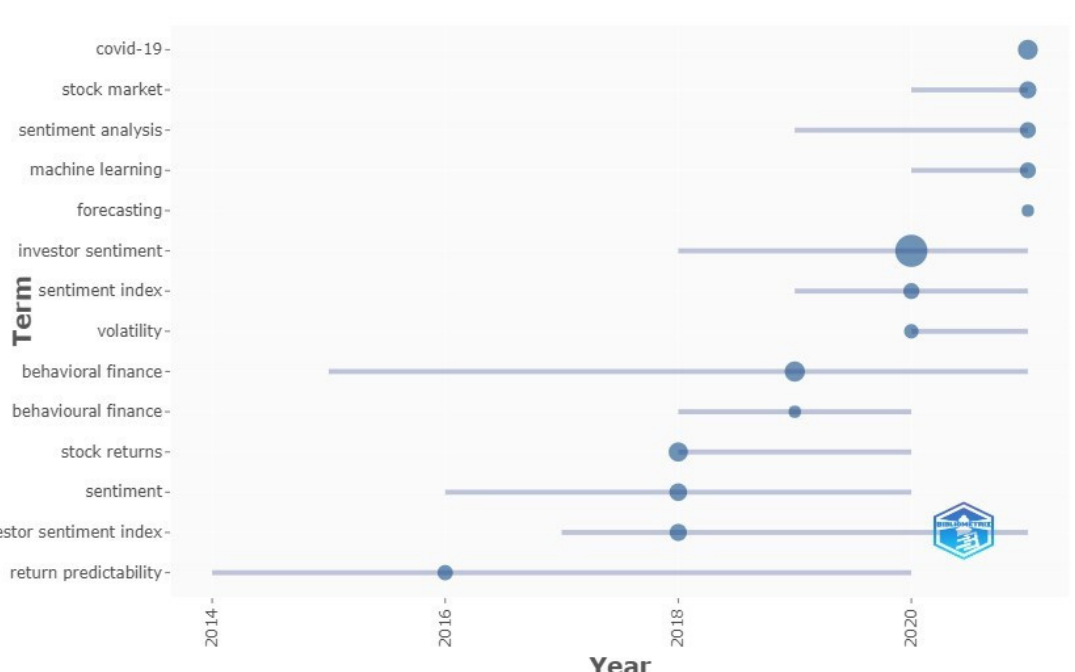
Figure 10. Mapping based on the keywords used by authors.